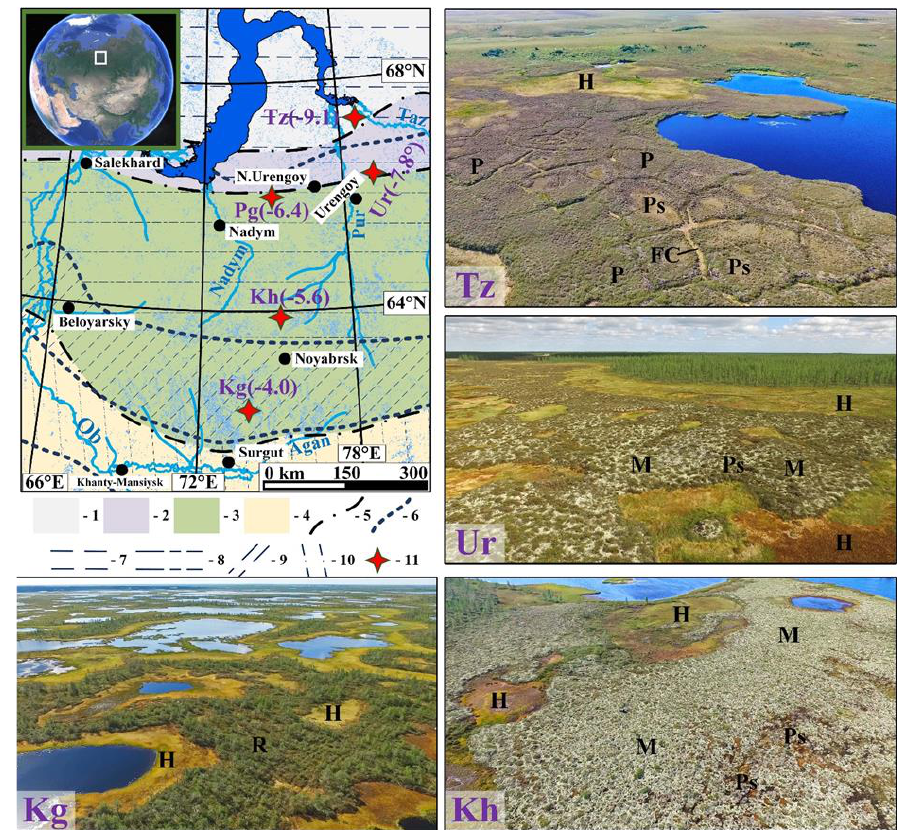
Figure 1. Map of the study site with permafrost boundaries (Brown et al., 2001; http://portal.inter-map.com, NSIDC), with five main test sites: Kogalym (Kg), Khanymey (Kh), Pangody (Pg), Urengoy (Ur), and Tazovsky (Tz). The mean annual temperatures are given in parentheses. The inserts represent aerial (drone-made) photos of main sites with the position of mound/polygon (M/P), hollow (H), frost crack (FC), and permafrost subsidence (Ps). On the Kogalym site, a hollow (H) – ridge (R) – lake complex is a dominating landscape type. The numbers on the legend represent the following: 1, tundra; 2, forest-tundra; 3, northern taiga; 4, middle taiga; 5, borders between natural biomes; 6, borders between permafrost zones; 7, continuous permafrost; 8, discontinuous permafrost; 9, sporadic permafrost; 10, isolated permafrost; 11, key study sites with mean annual temperature in the